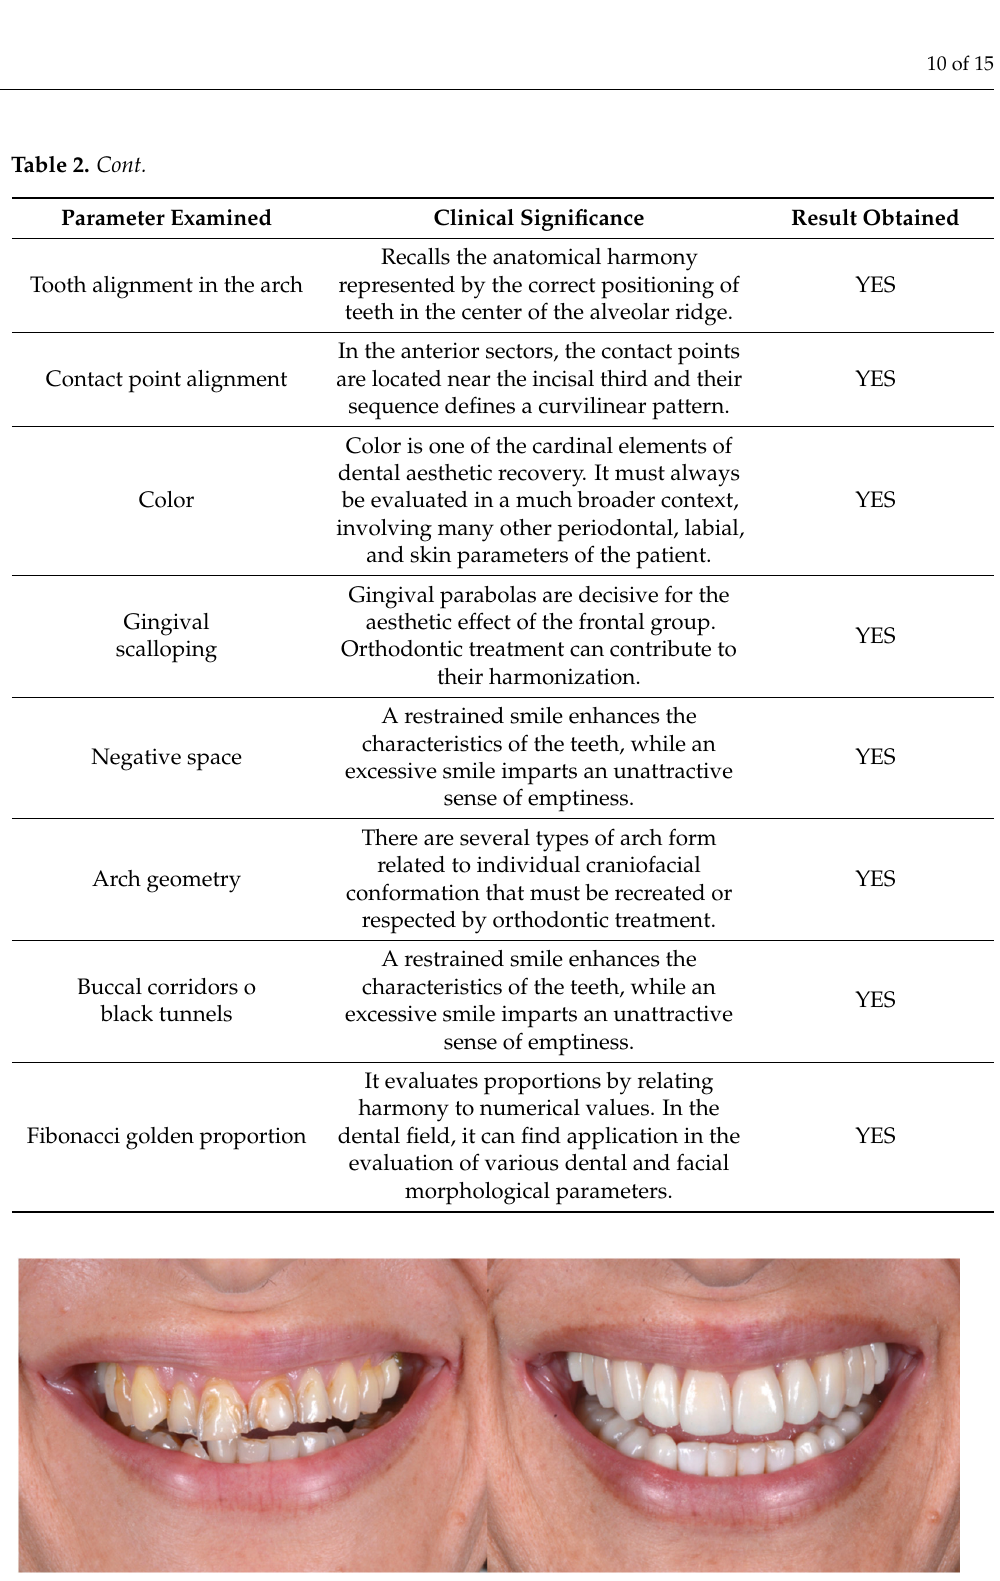
Table 2. Smile aesthetic parameters.